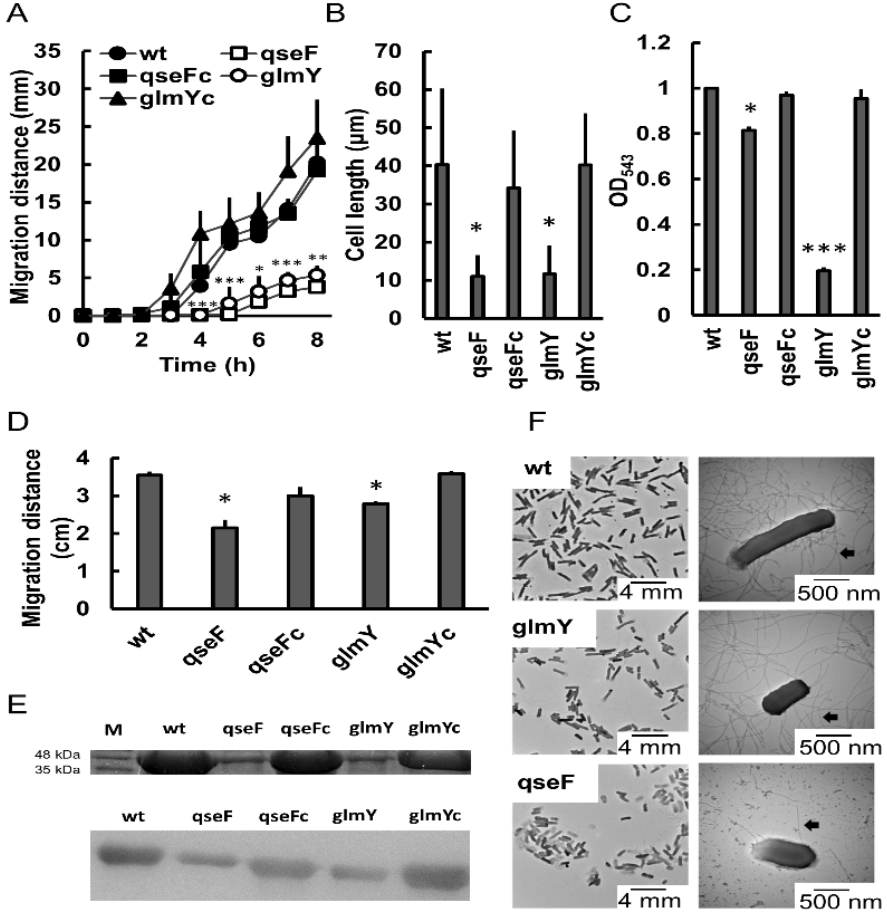
Figure 2. GlmY and QseF regulated swarming and related phenotypes. Swarming motility ( A ), cell length ( B ), hemolysin activity ( C ) and swimming motility ( D ) were determined in the wild-type, mutants of qseF and glmY and complemented strains. Swarming migration was monitored at 1-h intervals, and swimming motility was determined after incubation for 16 h. Cell length and hemolysin activity were determined at 5 h after incubation on the LB agar plate. The data are the averages and standard deviations of three independent experiments. Significant difference of qseF or glmY mutant from the wild-type at 4, 5, 6, 7 and 8 h is indicated (* p < 0.05; ** p < 0.01; *** p < 0.001 by the Student’s t test) in ( A ). Significant difference from the wild-type is indicated (* p < 0.05; *** p < 0.001 by the Student’s t test) in ( B – D ). ( E ) Analysis of flagellin expression by SDS-PAGE (upper panel) and Western blotting (lower panel). The flagellin level of the wild-type, mutants of qseF and glmY and complemented strains were examined at 5 h after seeding on the swarming plates by the SDS-PAGE and Western blotting as described in Materials and Methods. The representative picture of three independent experiments is shown. M, molecular weight marker. ( F ) TEM pictures of wild-type and mutants of qseF and glmY . Bacterial cultures were applied onto a carbon-coated grid, cells were stained with 1% PTA and TEM pictures were taken. Flagella are indicated by arrows. wt, wild-type; qseF, qseF mutant; glmY, glmY mutant; qseFc, qseF -complemented strain; glmYc, glmY -complemented